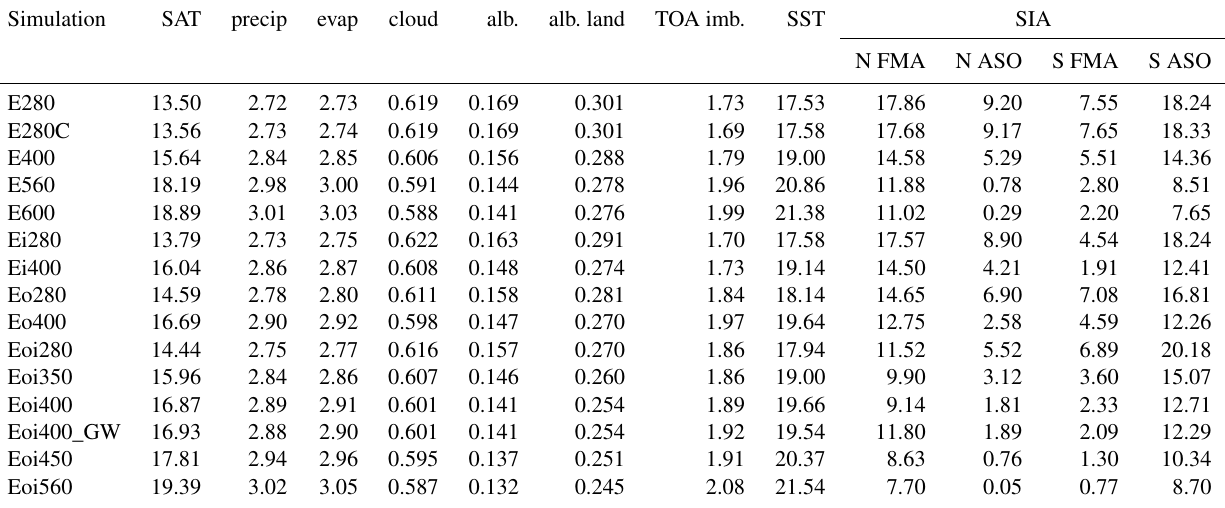
Table 2. Selected large-scale climate characteristics of equilibrium model simulations. Shown are global averages of surface air temperature (SAT at 2m above the ground in degrees Celsius), the sum of large-scale and convective precipitation (precip; mmd − 1 ), evaporation (evap; mmd − 1 ), cloud cover (cloud; fractional), surface albedo (alb.; fractional), land surface albedo (alb. land; fractional), radiative imbalance at the top of the atmosphere (TOA imb.; Wm 2 ), and sea surface temperature (SST, ◦ C; uppermost ocean layer). Furthermore, we show hemispheric averages of sea ice area (SIA) for boreal winter to spring (FMA) and summer to autumn (ASO) of Northern (N) and Southern (S) Hemisphere (10 6 km 2 ). Ocean characteristics have been computed after conservative remapping of ocean model output to a regular 1 ◦ × 1 ◦ grid. Seasonal sea ice is given for N and S based on the definition of Northern Hemisphere sea ice summer and winter (Howell et al., 2016). See text for details of the setup and configuration of the